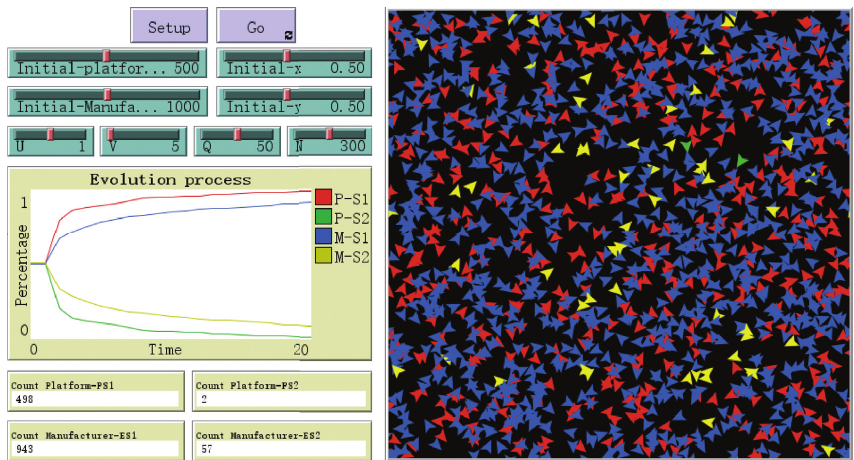
Figure 1: The simulation